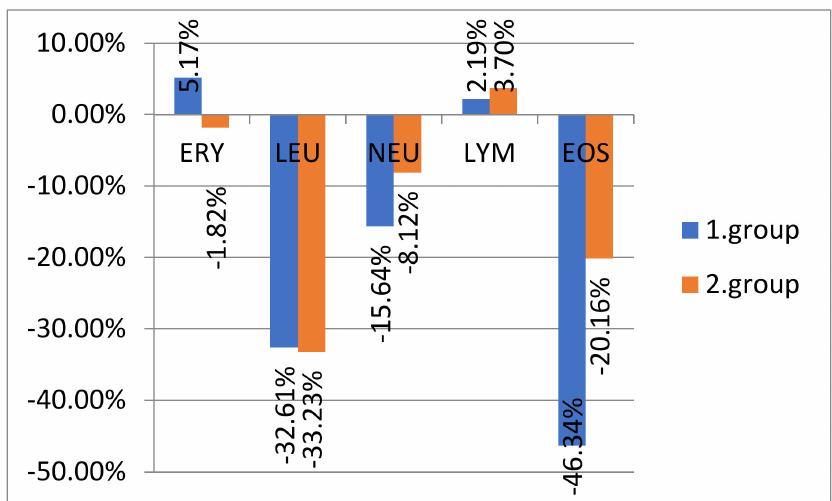
Figure 1. Percentage increase/decrease in averages of hematological indicators according to the analyzed groups after therapy. Legend: Ery, erythrocytes; Leu, leucocytes; Neu, neutrophils; Lym, lymphocytes; Eos, eosinophils; “1. group” is the group of dogs treated with acupuncture, phytother- apy and nutrition; “2. group” is the group of dogs treated with conventional Western medicine drug therapy.